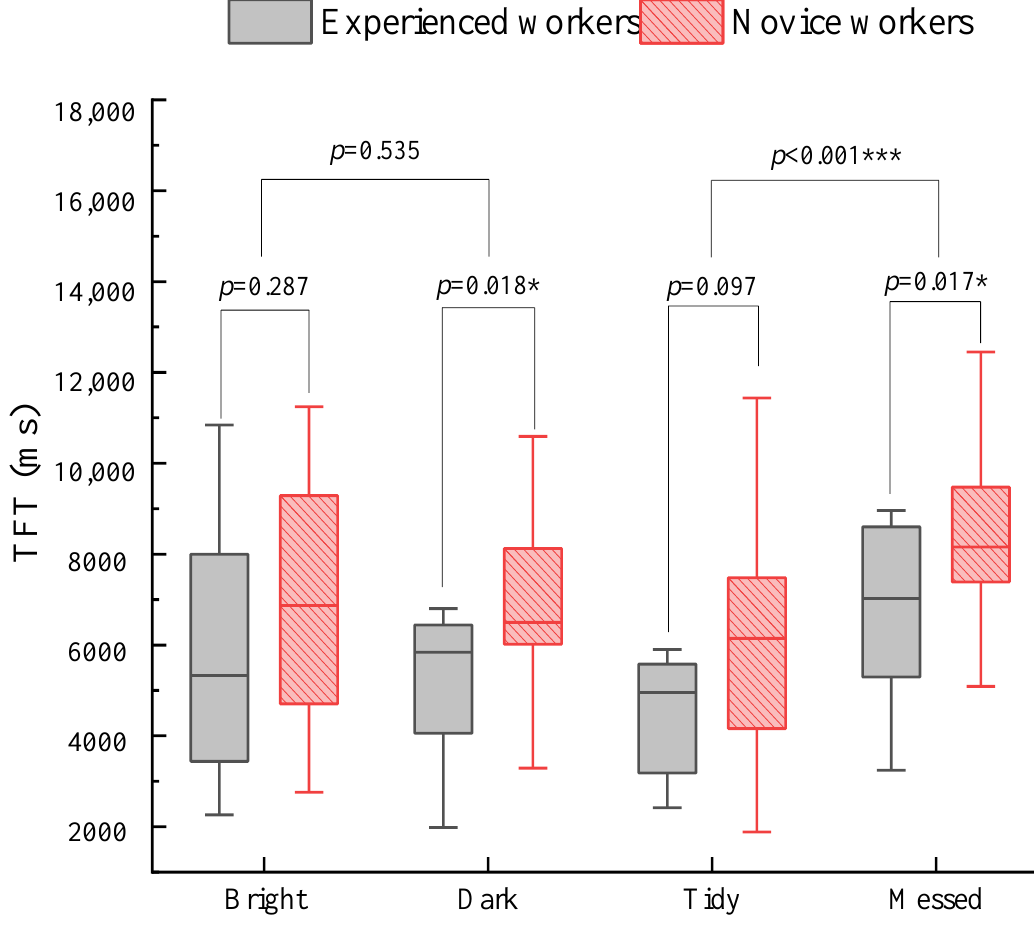
Figure 5. TFT for experts and novices in construction sites with different environmental conditions. (* and *** indicate significant differences at the 0.05 and 0.001 levels, respectively.)